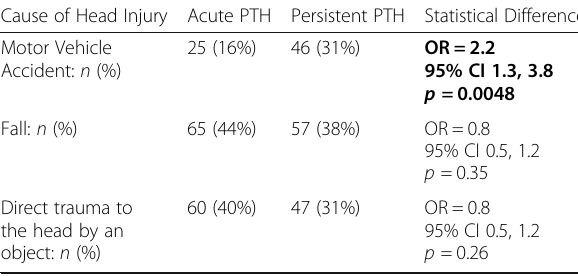
Table 2 Causes of head injury in the acute and persistent PTH